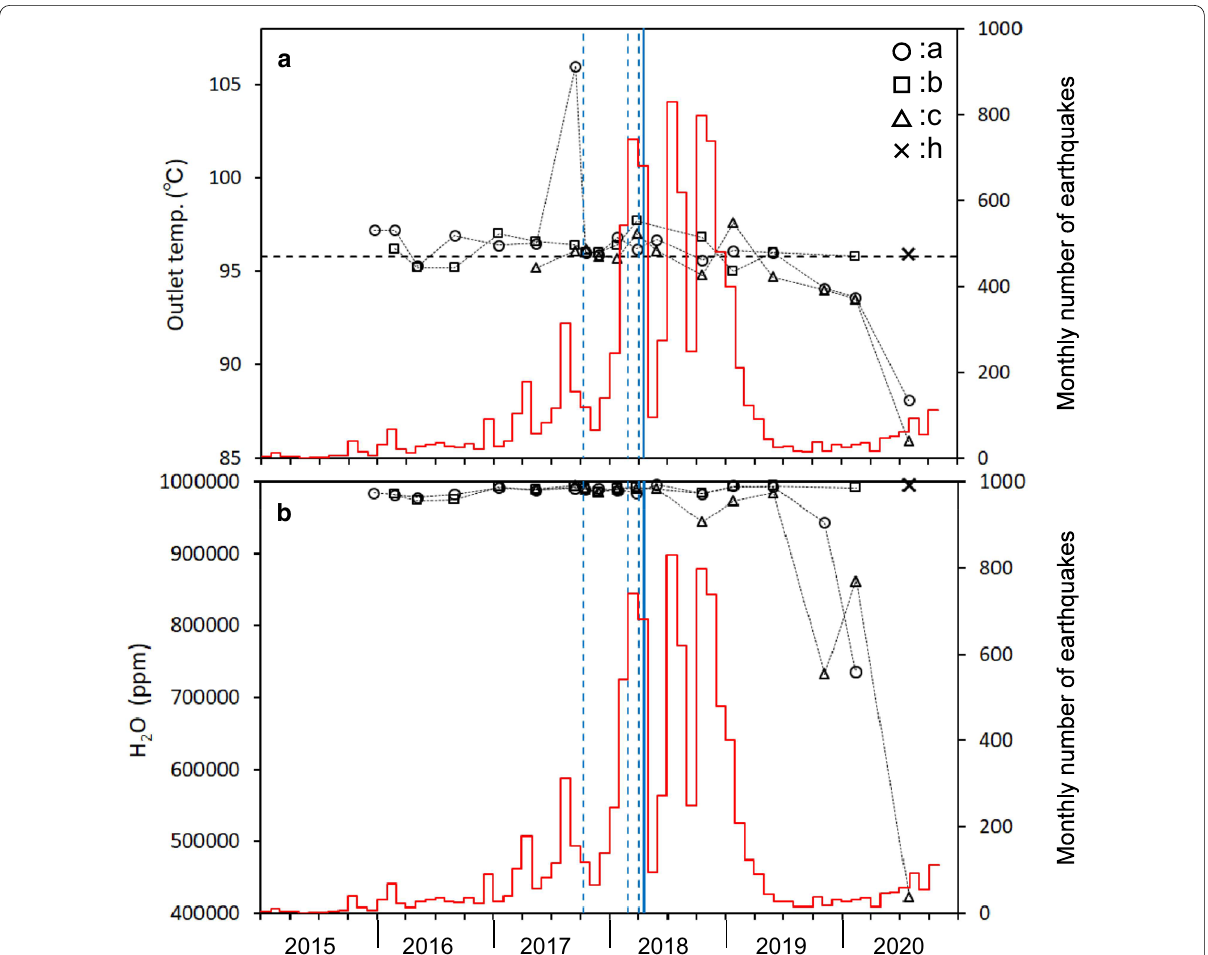
Fig. 3 a Changes in fumarolic gas outlet temperature. The horizontal broken line indicates the boiling temperature of water at fumarole altitude. b Changes in the H 2 O concentration of fumarolic gas. The red histograms in ( a ) and ( b ) indicate the monthly number of volcanic earthquakes observed by the JMA. The blue vertical solid line indicates the eruption at Ioyama volcano and blue vertical broken lines indicate eruptions